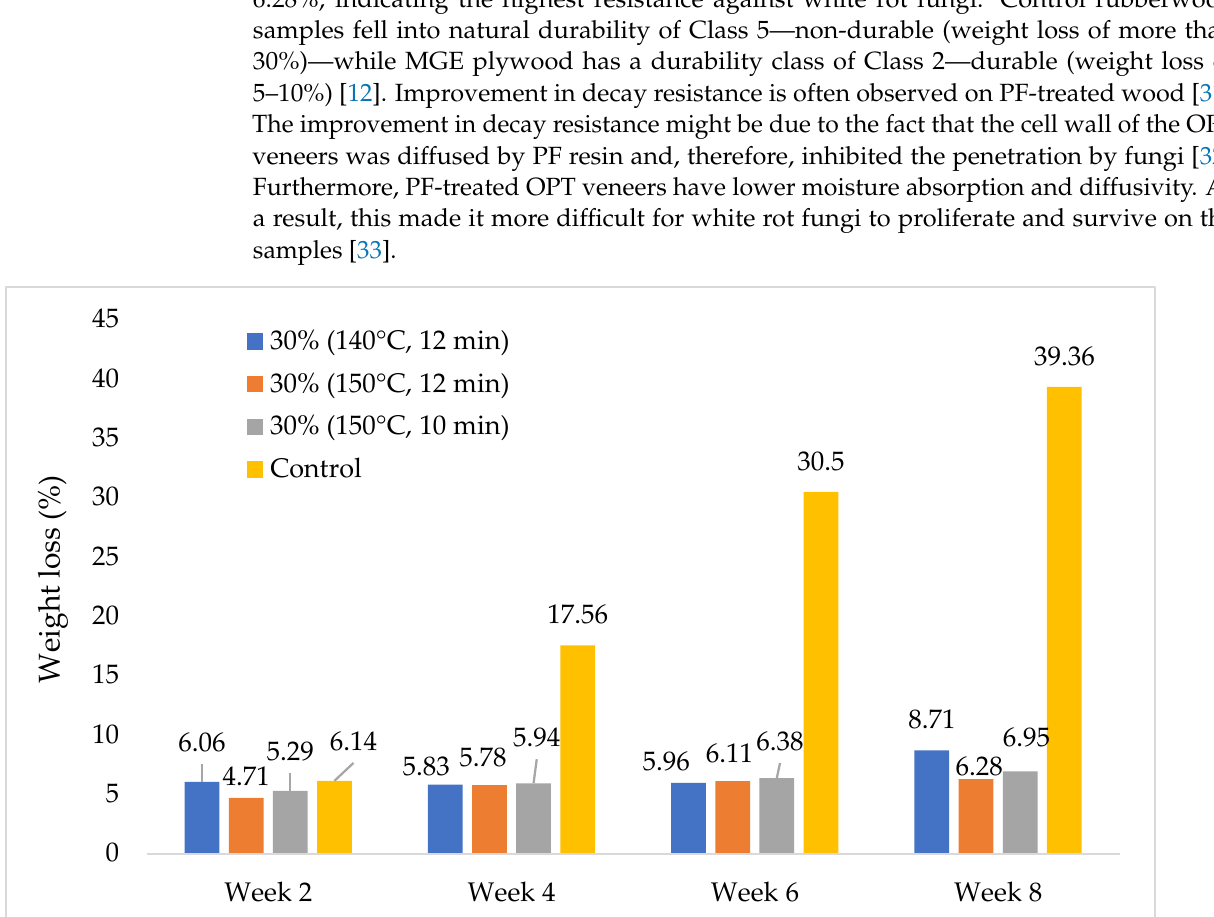
Figure 5. Fungal growth observation of the MGE plywood ( left ) and control ( right ) after 8-week exposure to white rot fungi.